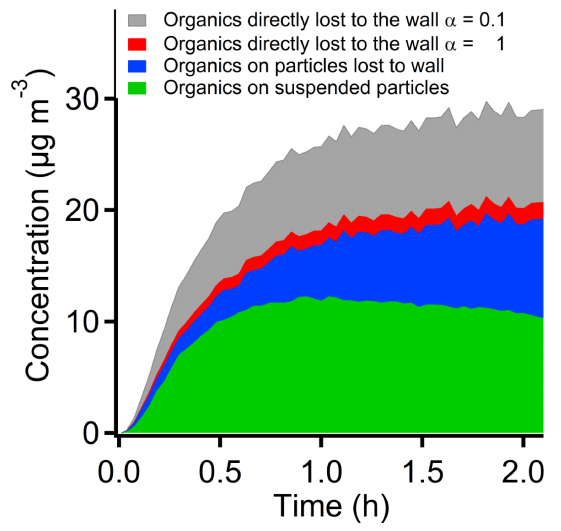
Figure 7. The SOA mass on the suspended particles, lost to cham- ber wall due to particle wall loss and direct vapor deposition on the chamber wall. When α = 0.1, the SOA mass lost to the cham- ber wall through the direct vapor deposition may have one third of the total SOA mass. When α = 1, the vapor wall loss may not be significant.